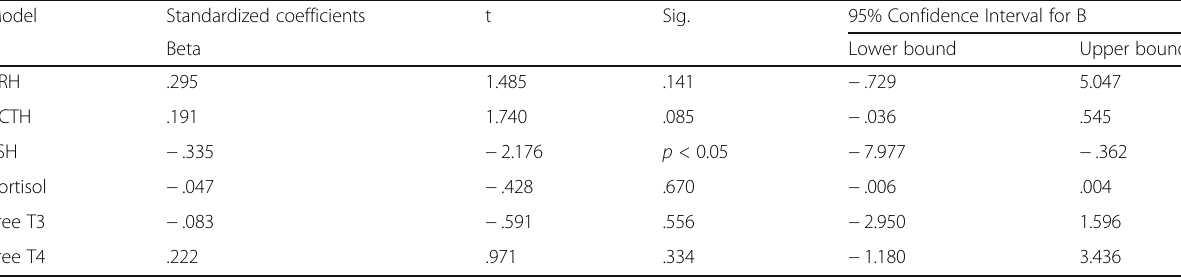
Table 7 The regression analysis for MoCA in patients with depression